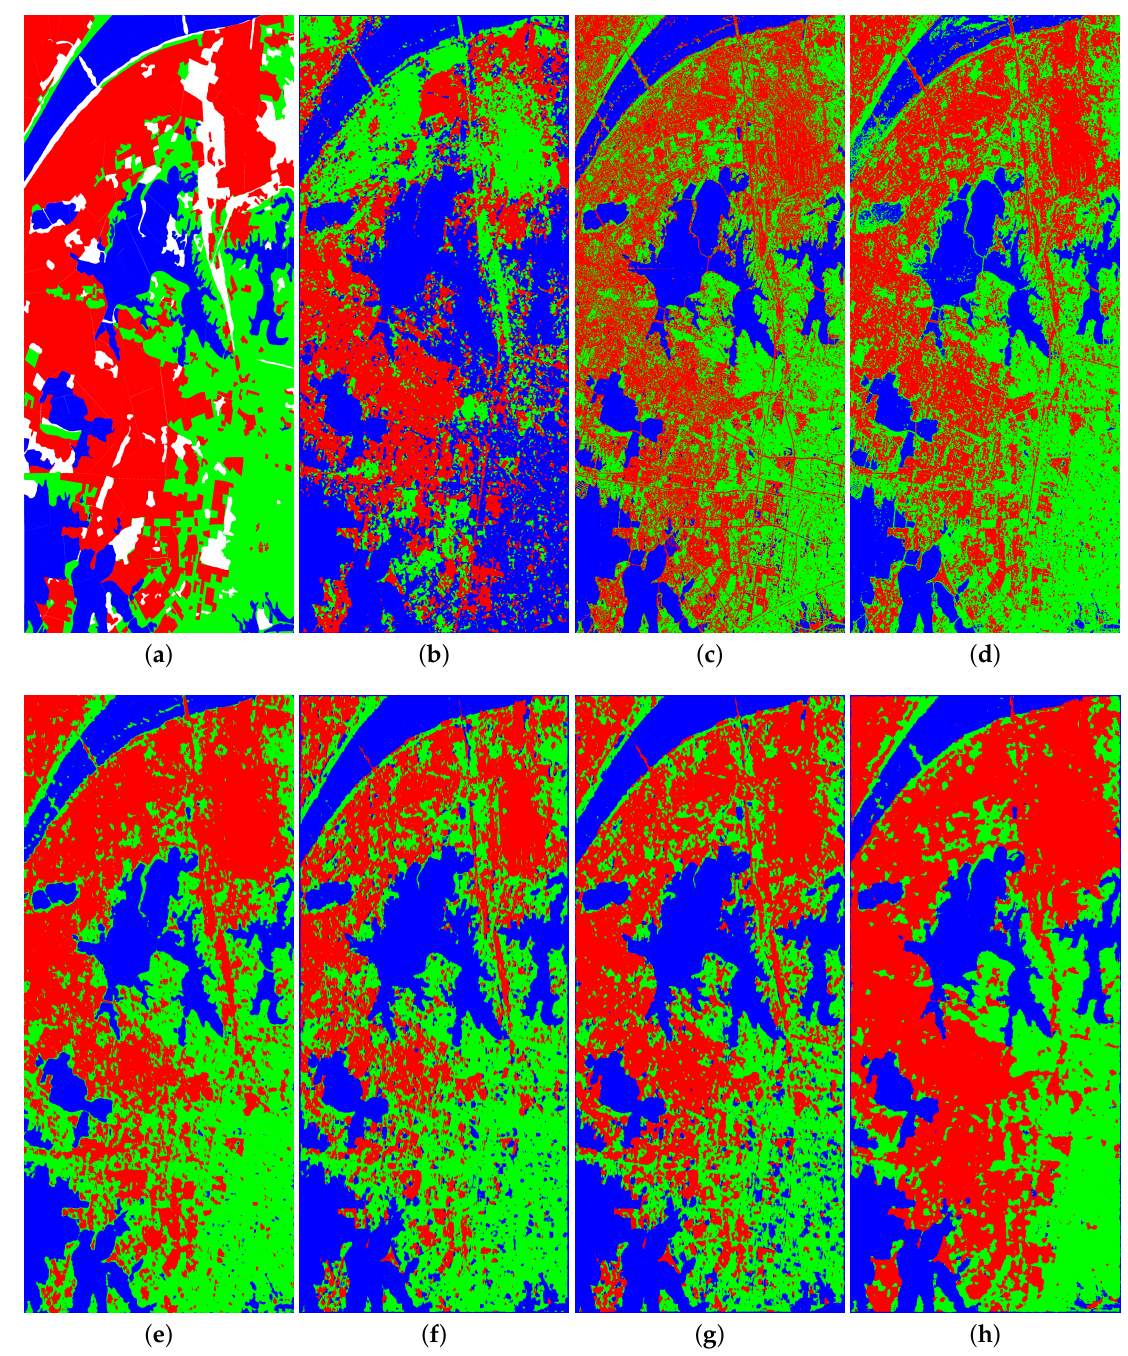
Figure 12. Classification results of RS-2 Wuhan dataset. ( a ) Ground truth map; ( b ) K-means; ( c ) Wishart; ( d ) ASC-S; ( e ) DAC; ( f ) DCCM; ( g ) DCCM+IIC; ( h )